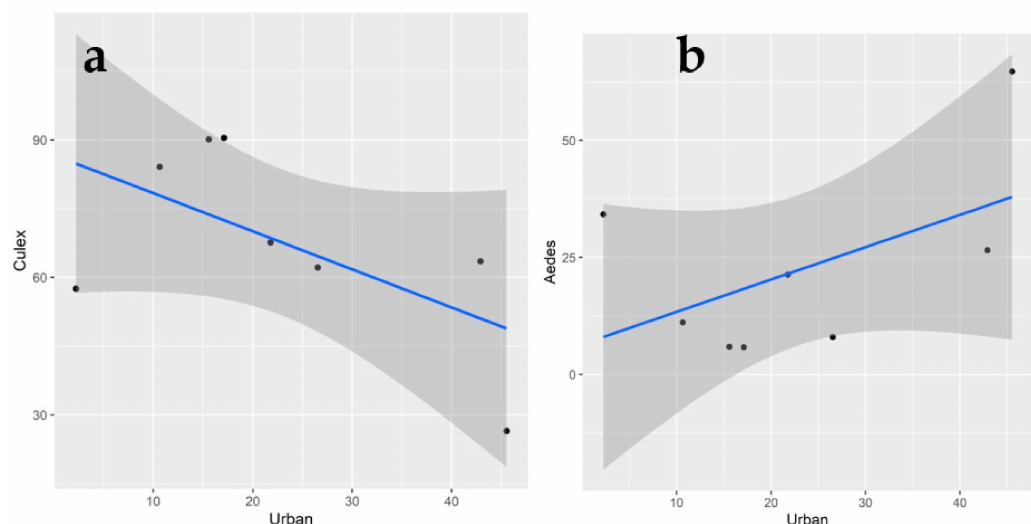
Figure 4. Frequency of Culex ( a ) and Aedes species; ( b ) collection and area of edification in each site in the S ã o Paulo